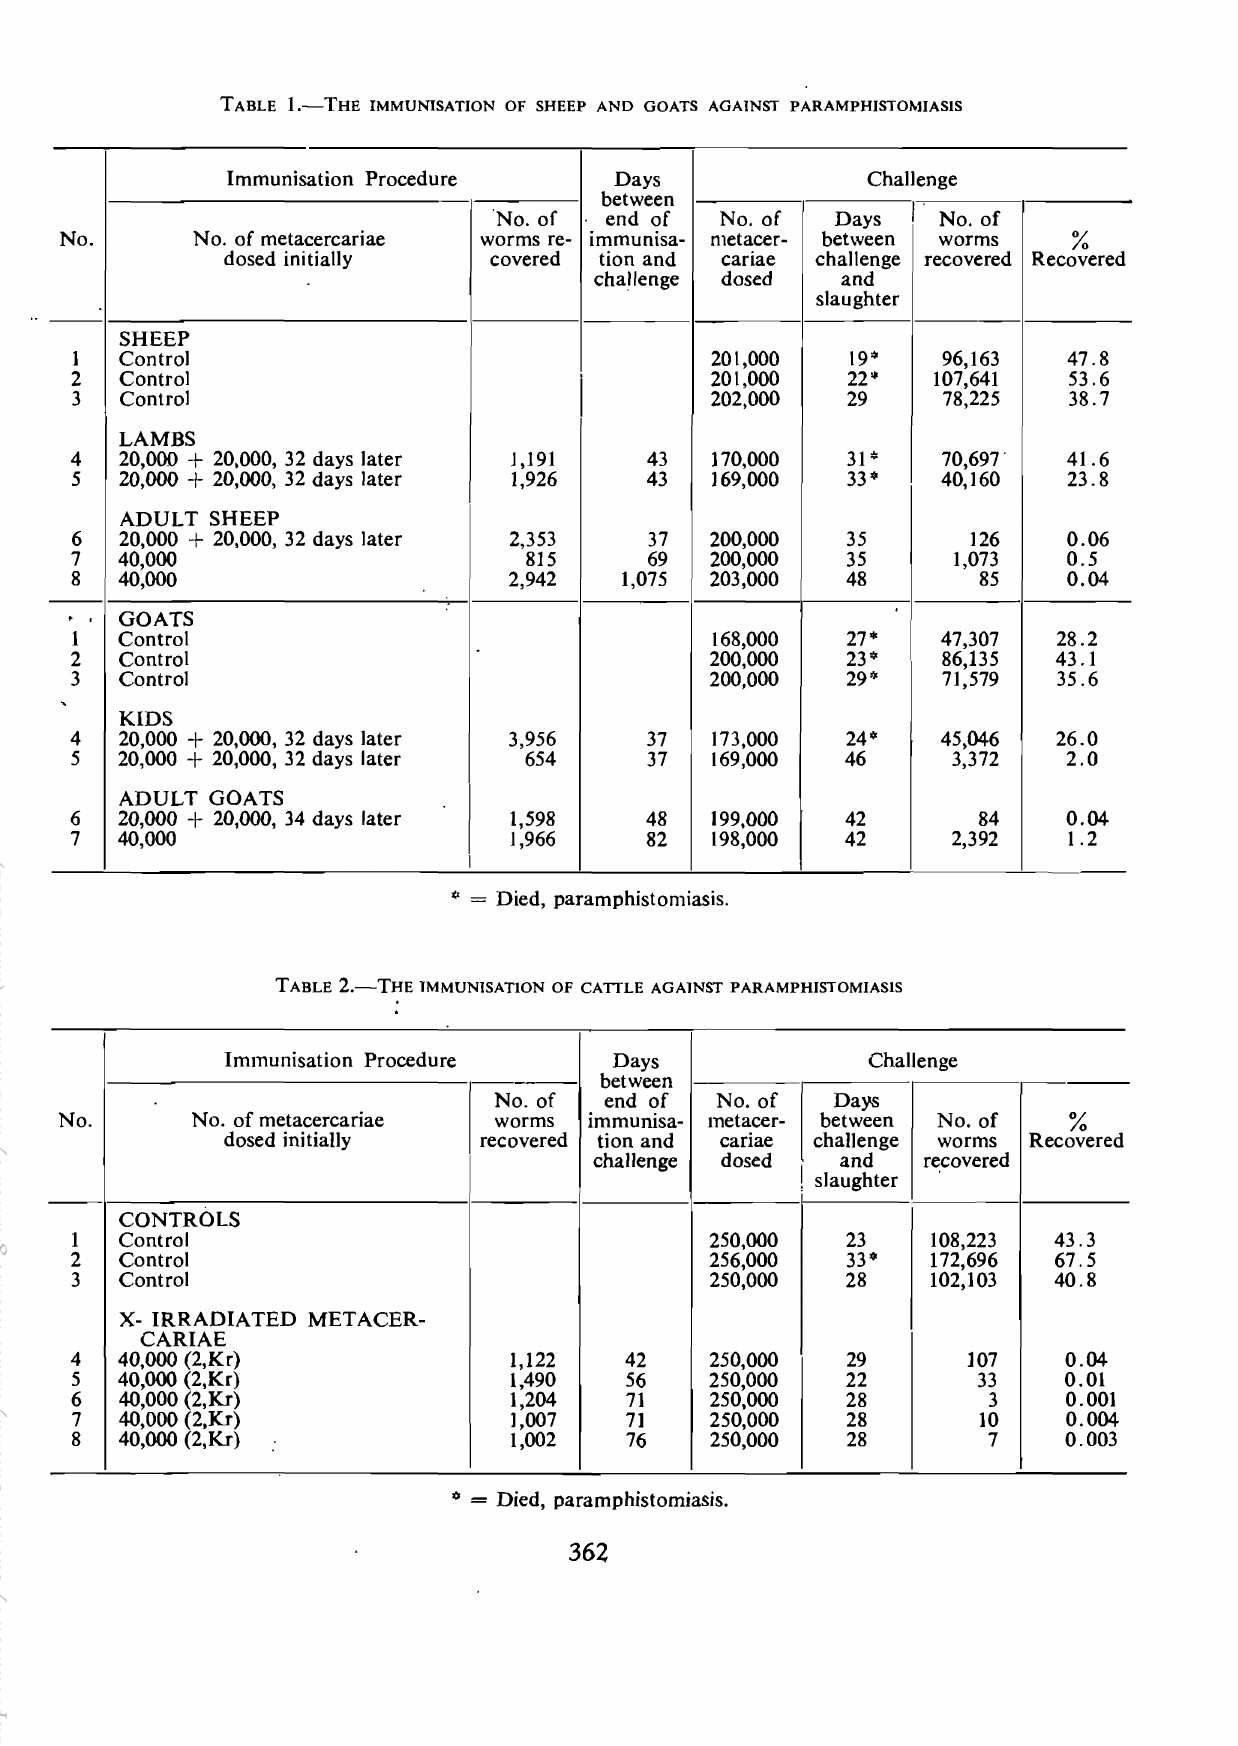
TABLE I.-THE IMMUNISATION OF SHEEP AND GOATS AGAINST PARAMPHISTOMIASIS